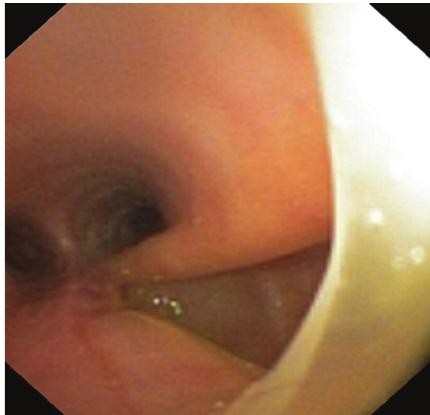
Figure 2: Prerepair bronchoscopic view of the tracheal tear.